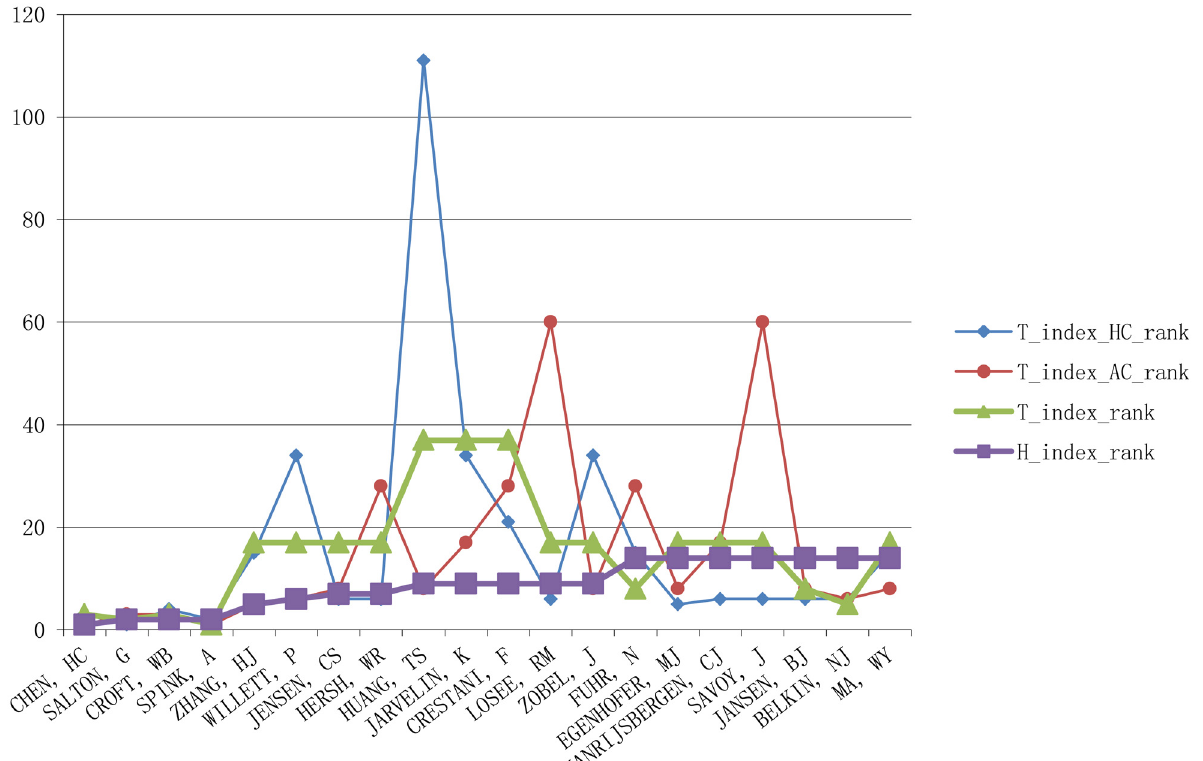
Fig 3. The comparision between ranks of t_index and h_index.